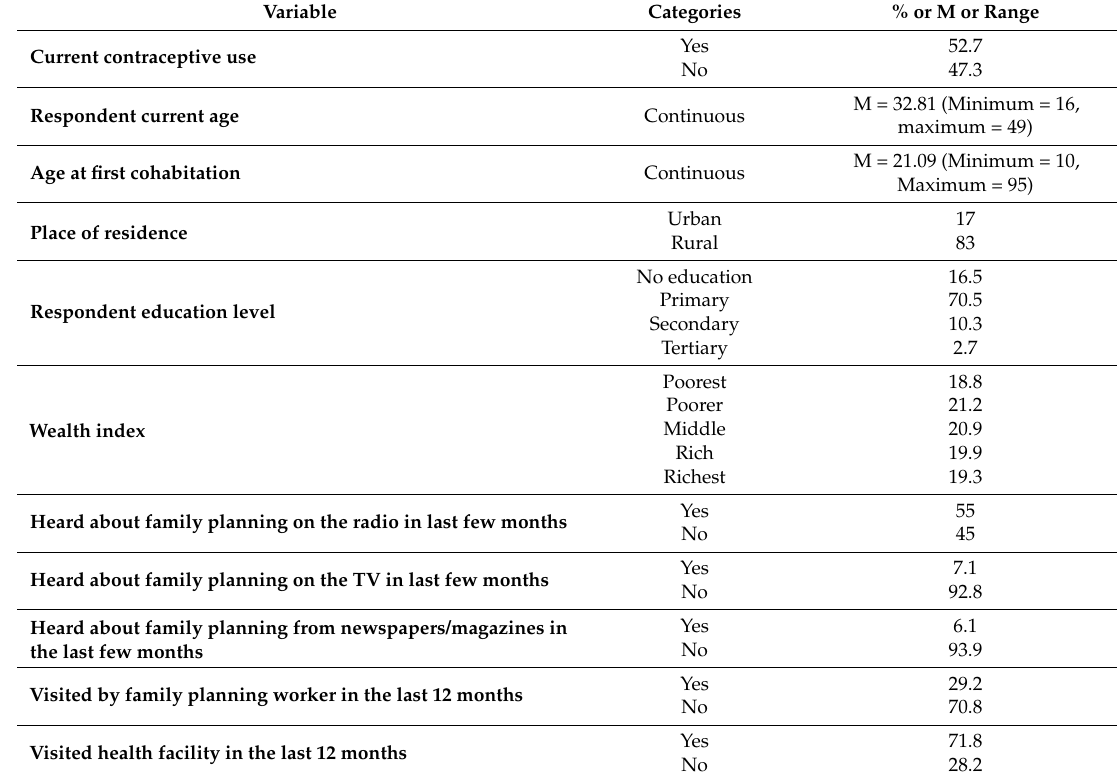
Table 1. Descriptive statistics of the participants’